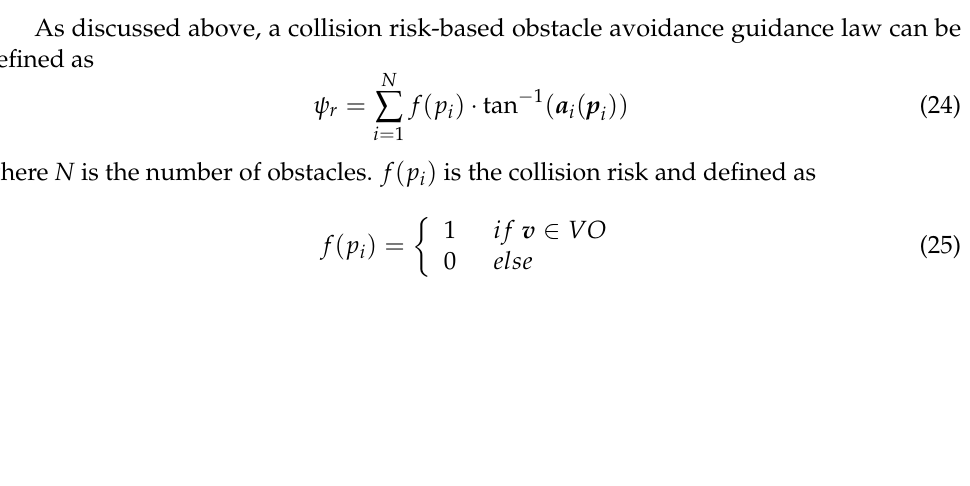
Figure 7. The proposed collision avoidance system for autonomous surface ships (( a ): geometry chart; and ( b ): the flowchart).